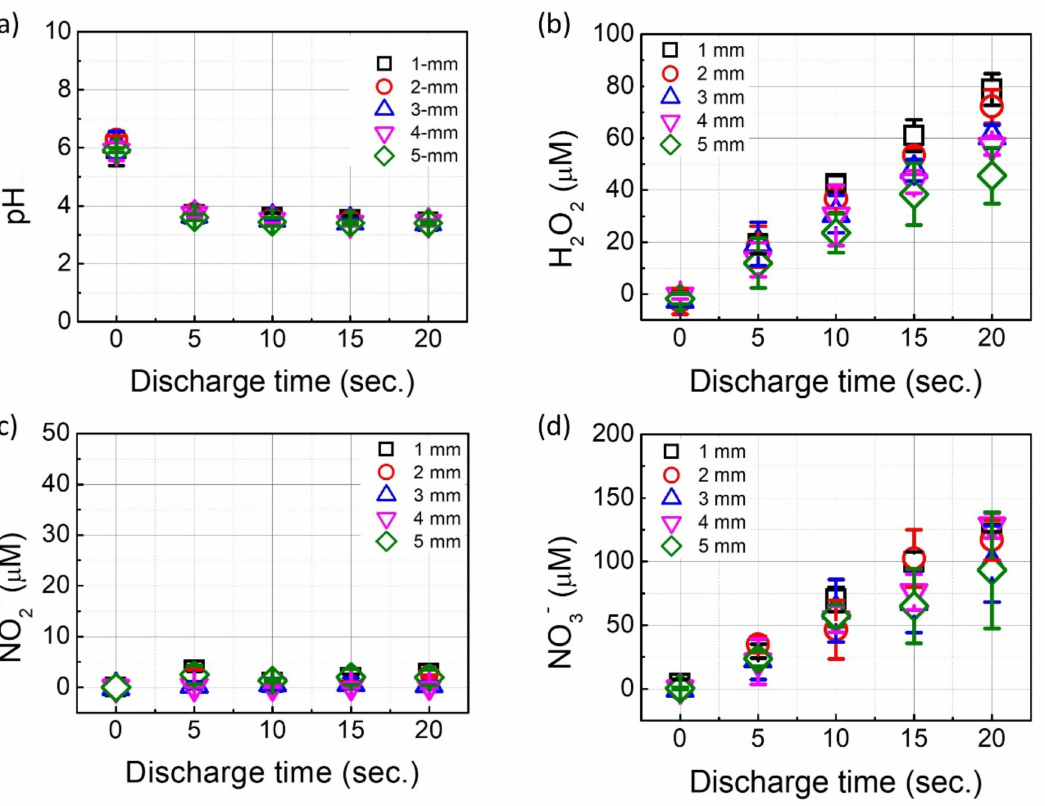
Figure 2. The characteristics of the plasma-treated liquid after different plasma treatment times and gap distances; ( a ) pH; ( b ) H 2 O 2 ; ( c ) NO 2 − ; and ( d ) NO 3 − . Results are presented as the mean ± stan- dard deviation from three independent